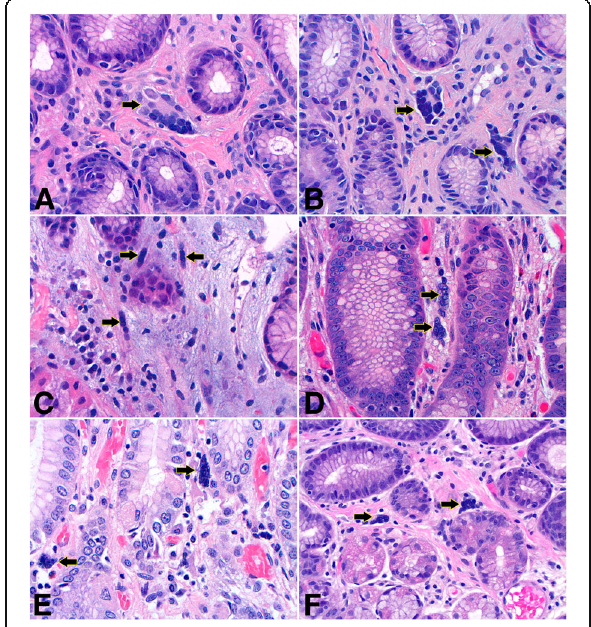
Fig. 1 Histological features of multinucleated stromal giant cells. ( a and b ) Wreath-like nuclei in a patient with reactive gastropathy. ( c and d ) Caterpillar-like nuclei in two patients with chronic inactive gastritis. ( e and f ) Morular-like nuclei in a gastroesophageal resection of esophageal adenocarcinoma status post chemoradiation therapy ( e ) and a GEJ biopsy with gastroesophageal reflux disease ( f ). Hematoxylin and eosin stain, original magnification 600x